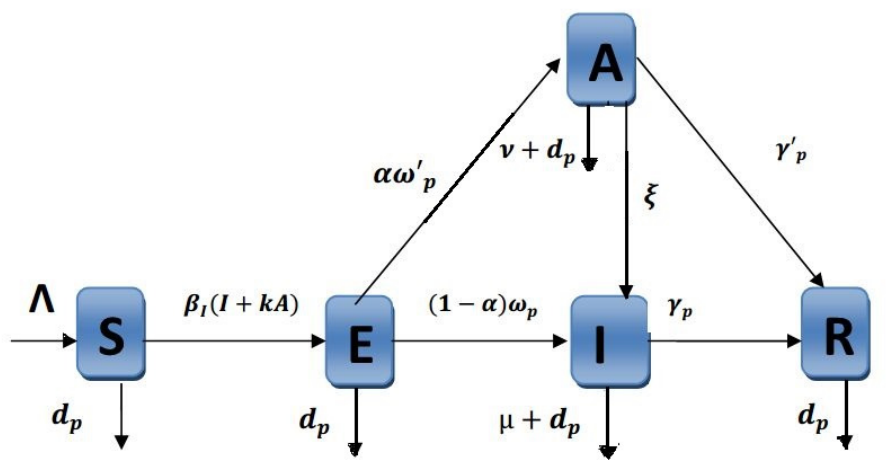
Figure 23. The basic interactions among the